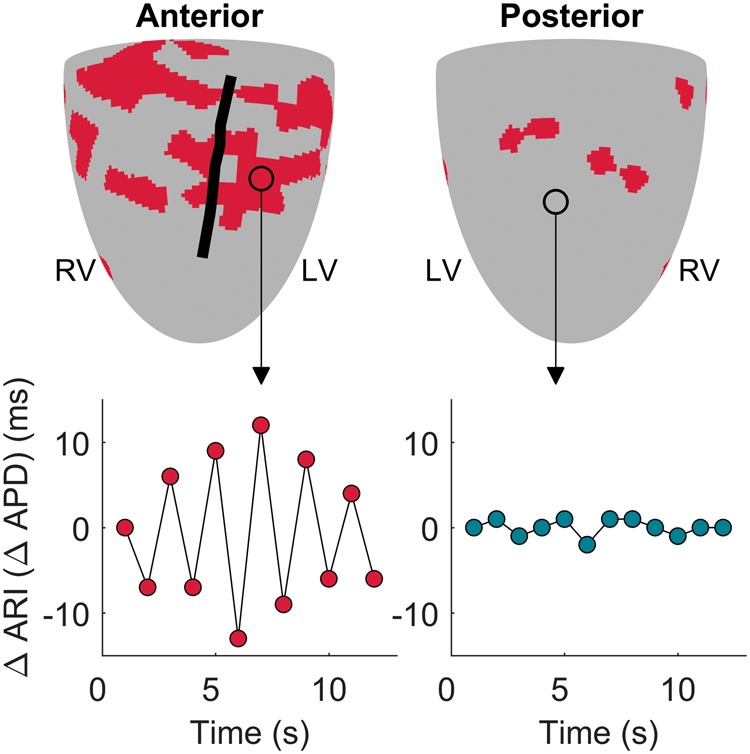
Mapping APD alternans. Map of alternans-susceptible sites (red) in one representative patient’s heart (upper panels). The black line represents the left anterior descending artery. Lower panels show beat-to-beat ARI fluctuations at an alternans-susceptible (left) and at an alternans-resistant (right) site. APD, action potential duration; ARI, activation-recovery interval; LV, left ventricle; RV, right ventricle.